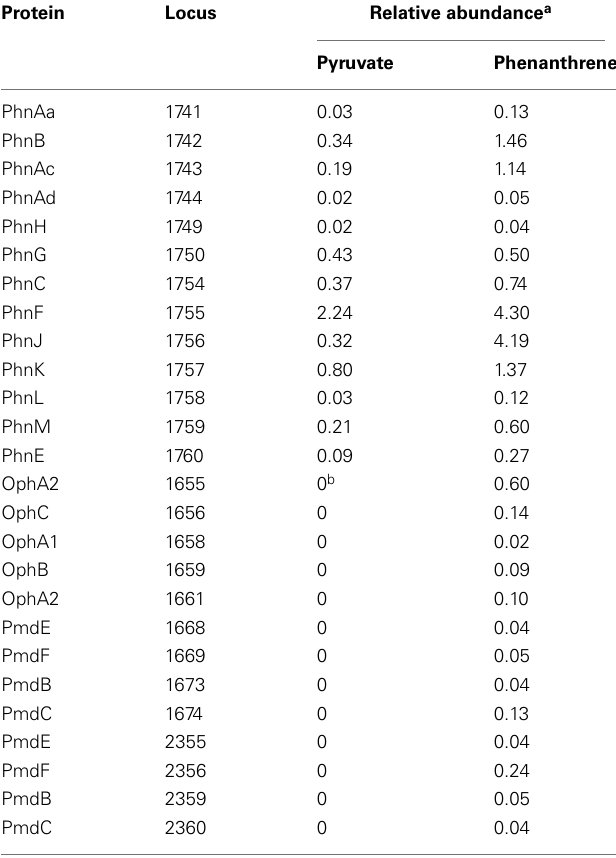
Table 5 | Comparative proteomic analysis of pyruvate- and phenanthrene-grown cells of Delftia sp. Cs1-4.